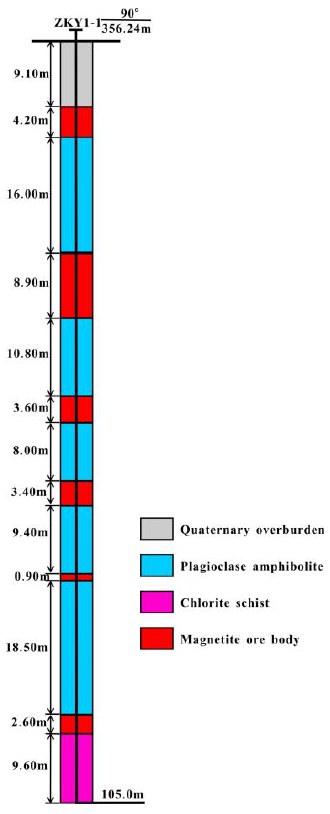
Figure 9. Diagrammatic cross‐section from the validation by drilling.